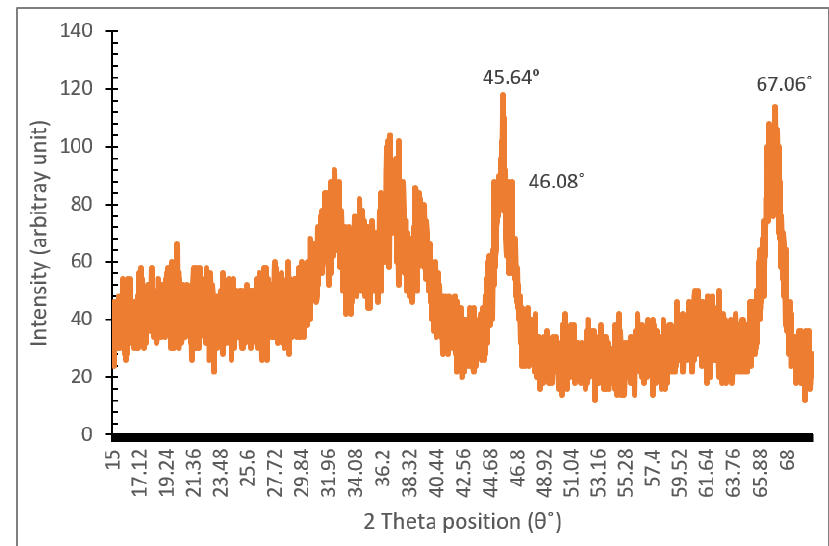
Figure 3. XRD spectra of Al 2 O 3 nanoparticles.